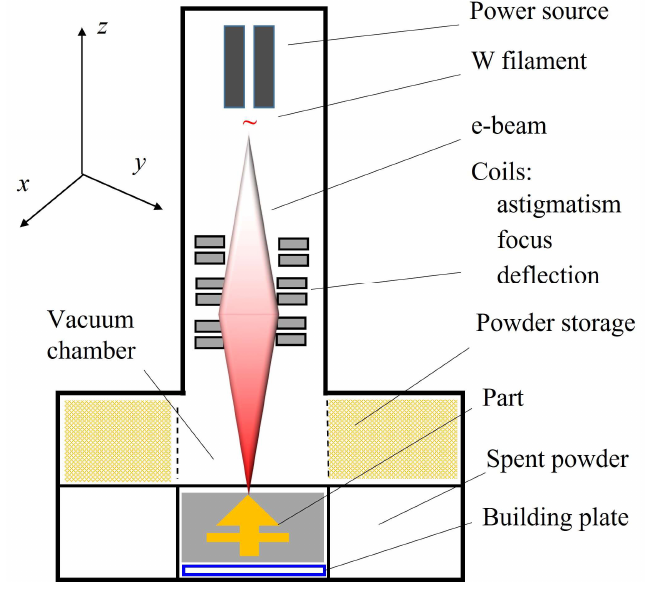
Figure 1. Schematics of EBM.